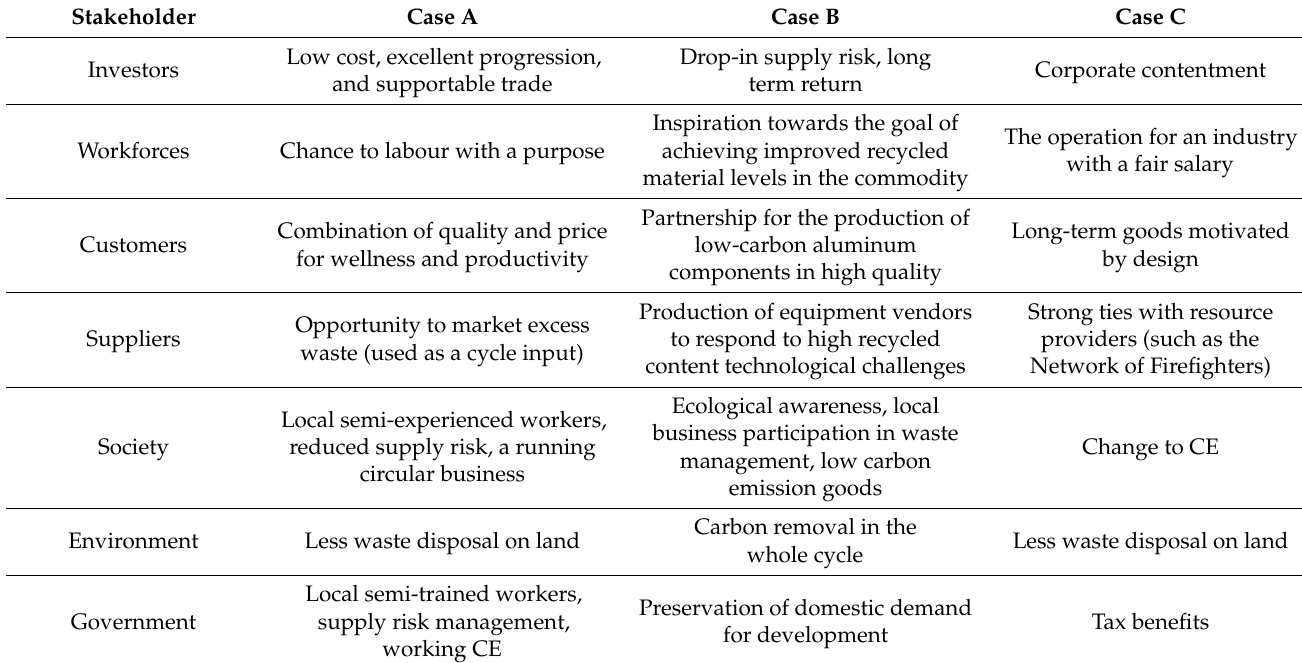
Table 1. Proposed SCBM taken by stakeholders for three cases A, B, and